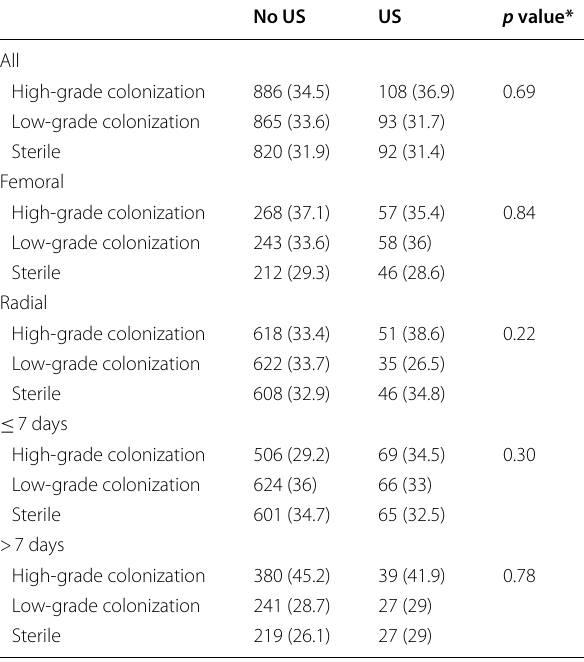
Table 3 Skin colonization at catheter removal (main group and subgroup